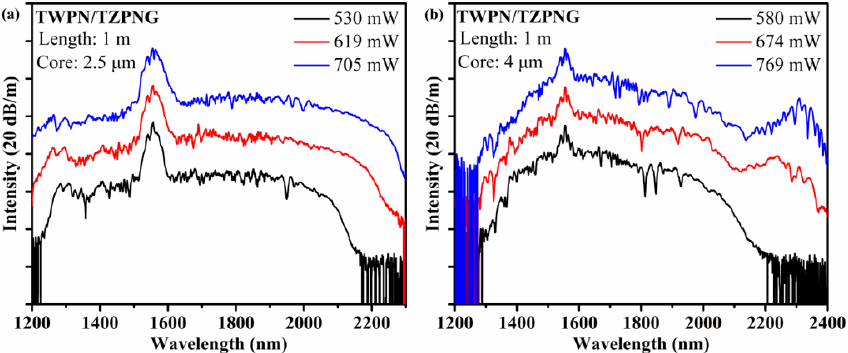
Figure 4. SC spectrum in the TWPN/TZPNG fibers with different core diameter ( a ) 2.5 μm; ( b ) 4 μm. TBZL/TWZN fiber with a diameter of 3 μm and length of 0.3 m was used as a